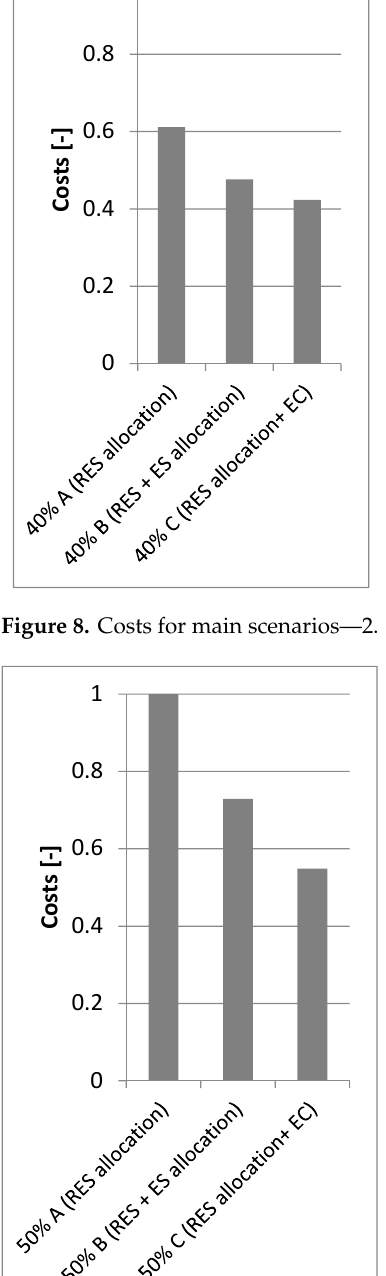
Table 4. Computation time and number of variables.